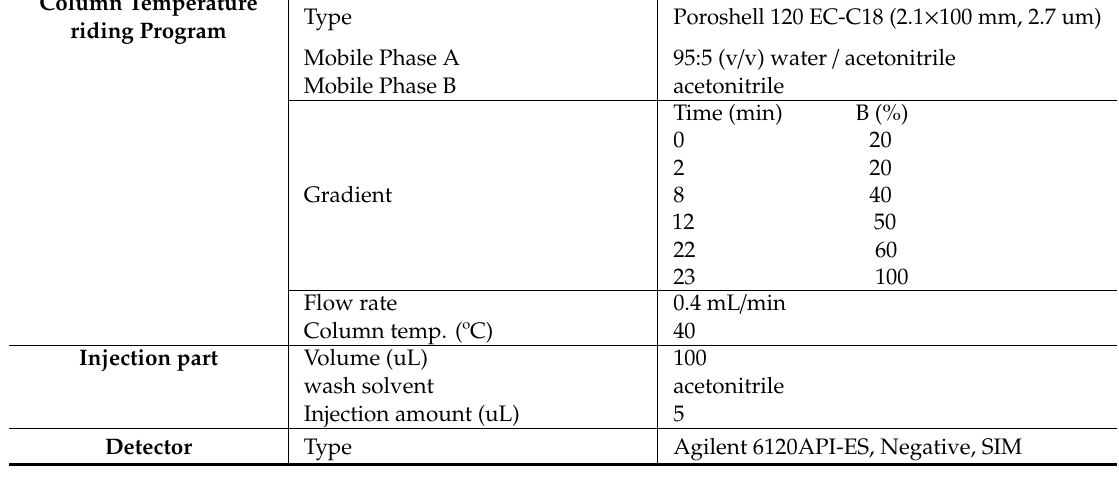
Table A3. Experimental setup of liquid chromatography–mass spectrometry (LC-MS). Column